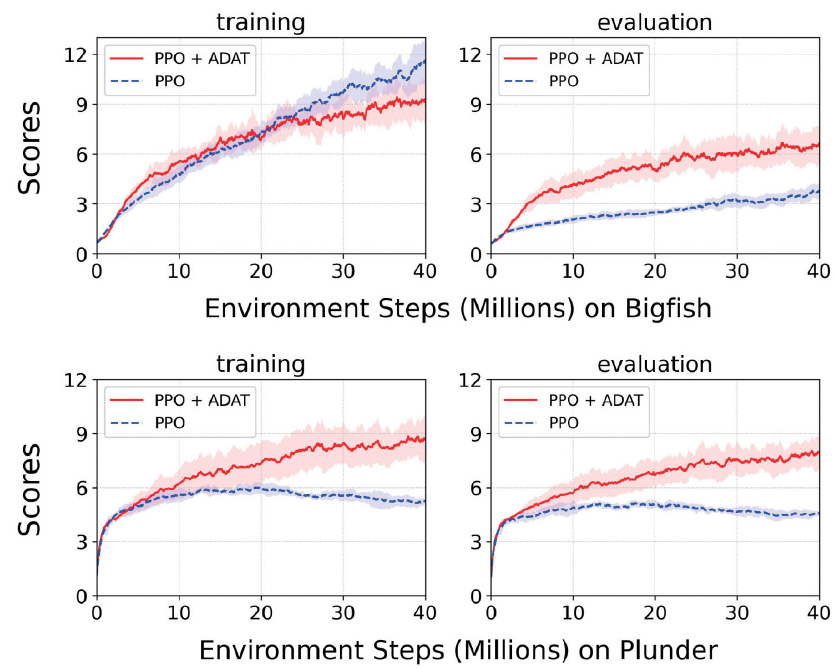
Fig 5. Comparison of generalization capability. Bigfish and Plunder Games in OpenAI Progen. 200-levels trained agents were evaluated on 100,000 levels. On-policy ADAT leveraged the samples rolled out by PPO policy. A difference in both frameworks is contrastive representation learning through ADAT. This figure reports the average score and standard deviation over five random seeds.